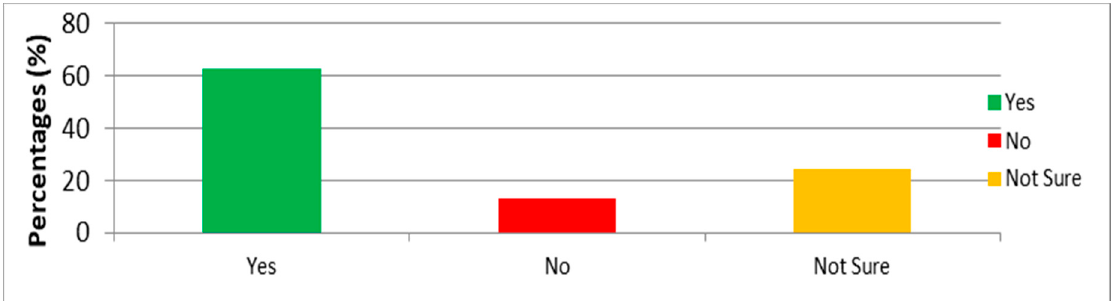
Figure 2. Acceptance and rejection of UDT.